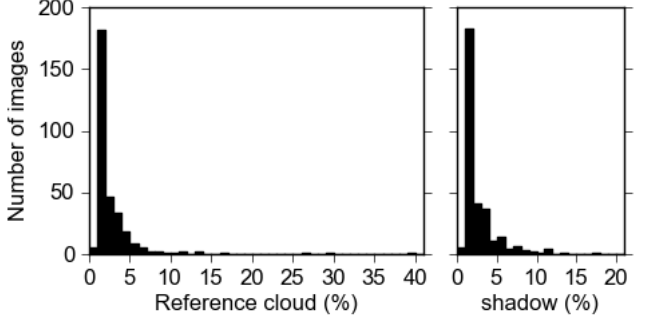
Figure 4. Histograms of the amount of cloud and shadow in the 313 SPOT5 HRG reference images used for training and